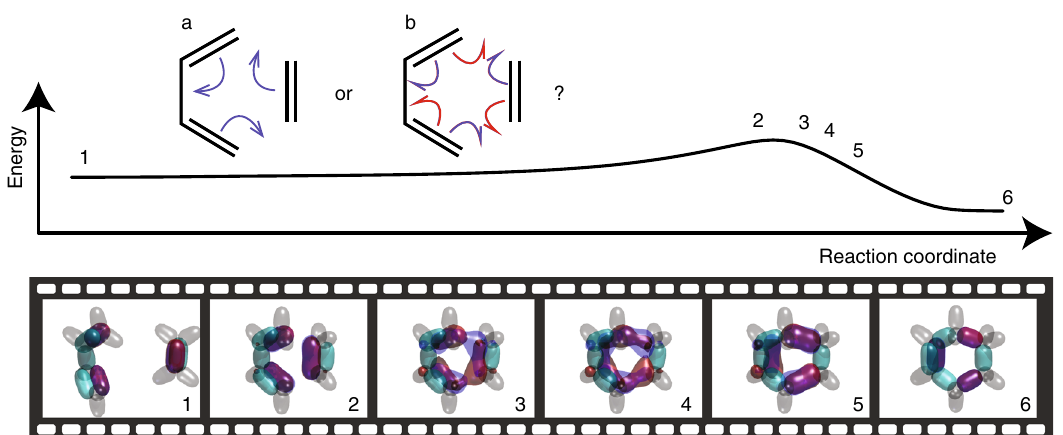
Fig. 6 The evolution of one wavefunction sub-tile along the Diels – Alder reaction coordinate. While frequently drawn as concerted electron pair motion